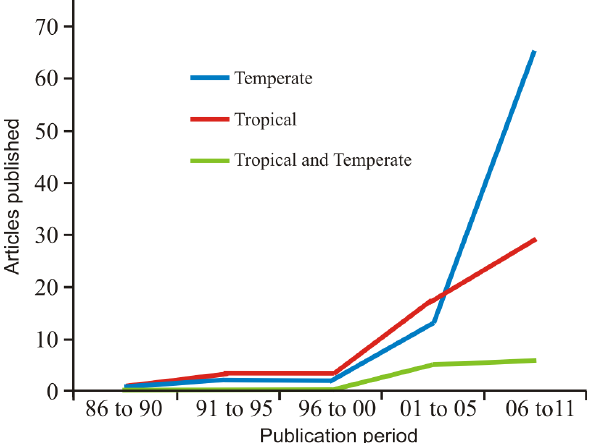
F IGURE 4. Overall number of studies produced in each one of the Climate zones by period (N= 219)